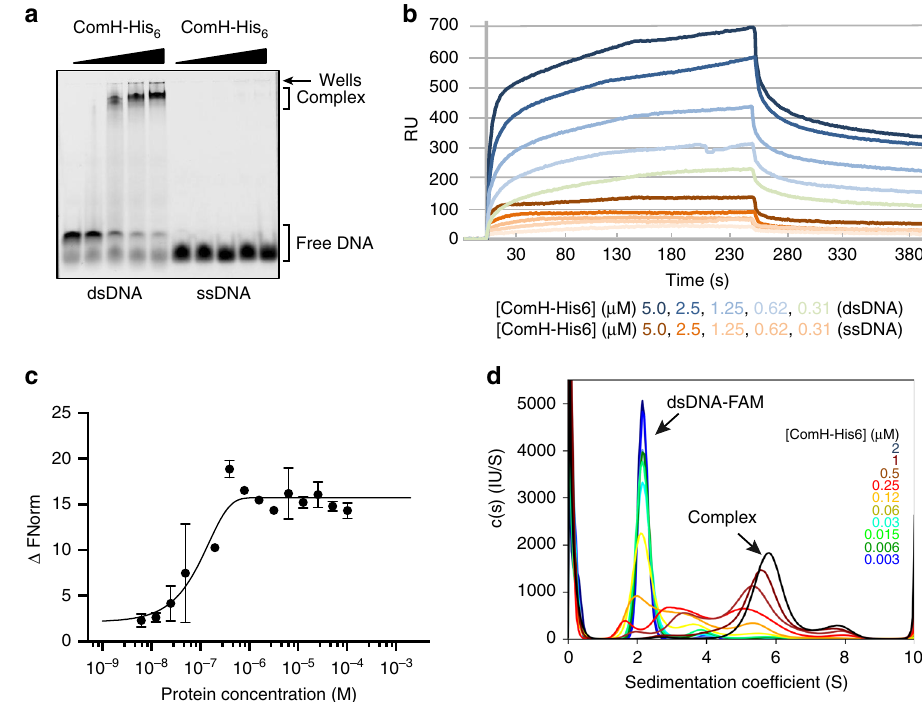
Fig. 3 ComH is a double-stranded DNA- binding protein. a Visualisation by electrophoretic mobility shift assays of nucleoprotein complexes formed by ComH-His 6 . Increasing concentrations of puri fi ed ComH-His 6 (0, 0.5, 1, 1.5, and 2 µ M) were incubated with Cy5-labelled dsDNA (18 bp) and ssDNA (18- mer) substrates (30 nM). The free DNA substrates and nucleoprotein complexes were resolved by native PAGE (6%). b Comparison of ComH-His 6 binding to dsDNA (50 bp) and ssDNA (50-mer) by Surface Plasmon Resonance. Increasing concentrations of ComH-His 6 (0, 0.31, 0.62, 1.25, 2.5, and 5 µ M) in binding buffer (PBS + 0.005% Tween20) were injected onto the streptavidin chip containing immobilised DNA substrates. The SPR derived sensograms for dsDNA and ssDNA are shown. c Interaction measurements by microscale thermophoresis of the af fi nity between ComH-His 6 and a 18 bp DNA labelled with a FAM in 5 ’ . All experiments were performed in duplicate and error bars = SD. d Analyses by sedimentation velocity analytical ultracentrifugation (SV-AUC) of the interaction between ComH and 18 bp dsDNA-FAM. The free dsDNA-FAM has a sedimentation coef fi cient of 2.1S. ComH forms a main complex with a sedimentation coef fi cient of but not for ssDNA (Supplementary Fig. 5a). The nucleoprotein stable up to 600 mM of either NaCl or KCl (Supplementary dsDNA using this assay (Supplementary Fig. 5c).